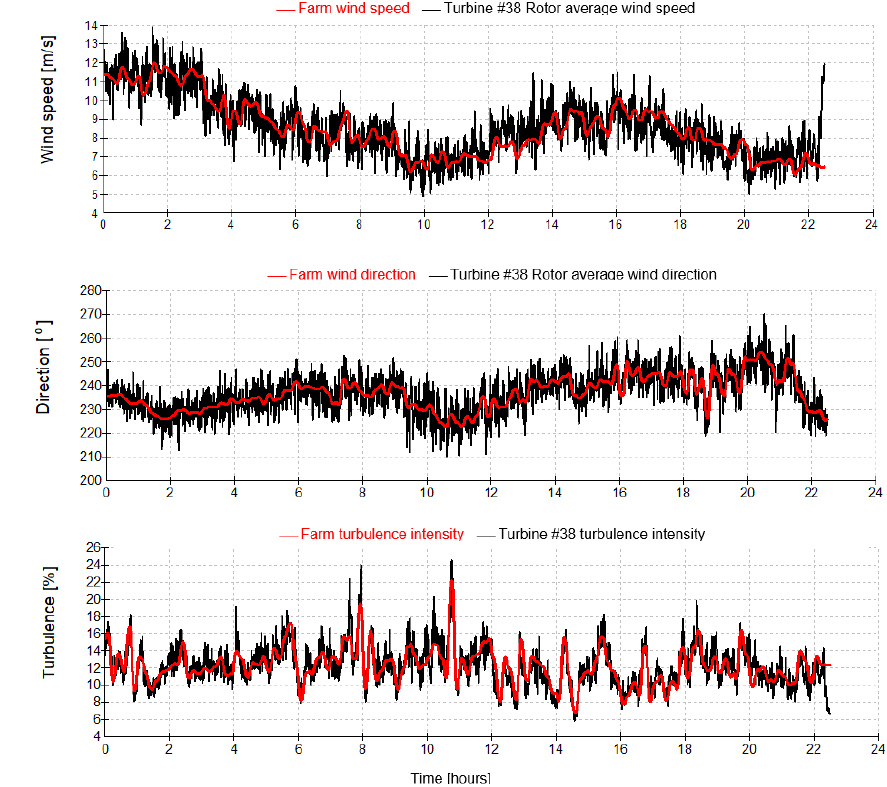
Figure 10. Wind conditions for the toggling simulations. The red line represents the smoothed 10min mast data and is assumed to apply at a point halfway down the row of turbines. The black line shows conditions from the simulated wind field at the turbine no. 38